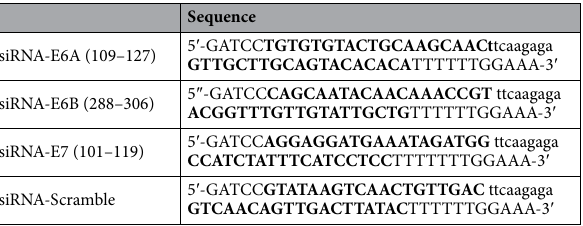
Table 1. The sequences of siRNA-E6A, siRNA-E6B, siRNA-E7 and